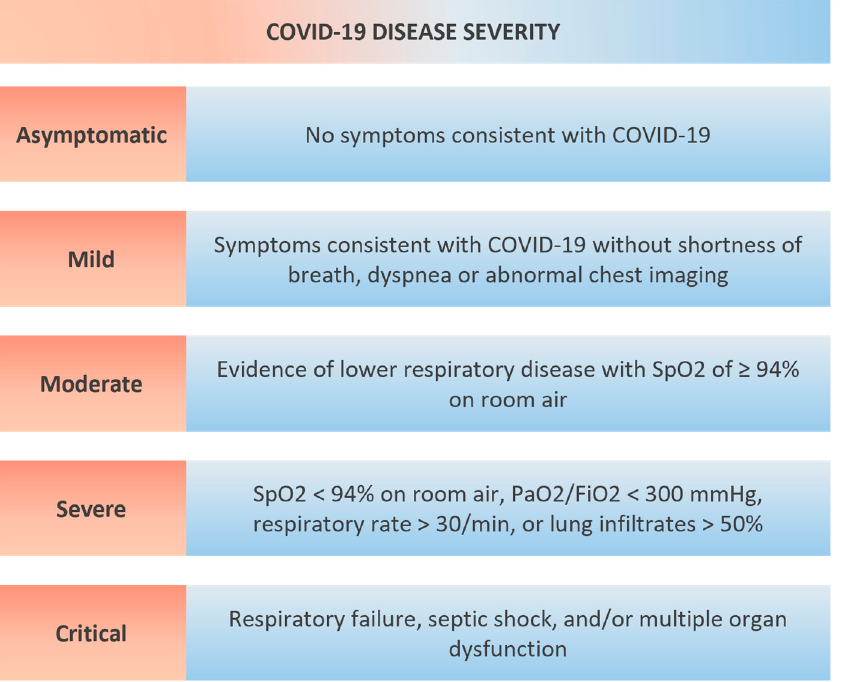
Figure 1. Severity of COVID-19. SpO2—oxygen saturation, PaO2/FiO2—arterial partial pressure of oxygen to fraction of inspired oxygen ratio.